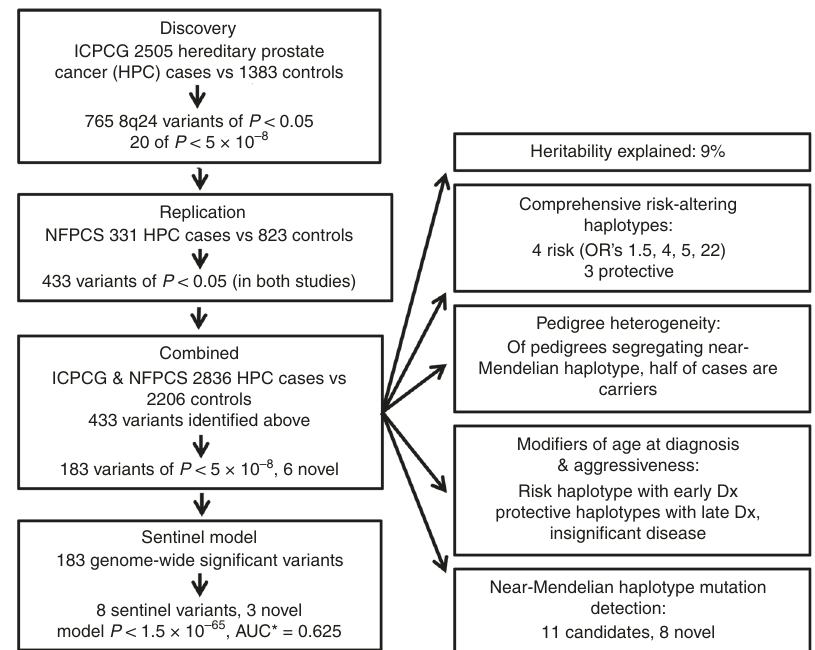
Fig. 1 Study overview. HPC hereditary prostate cancer, ICPCG International Consortium for Prostate Cancer Genetics, NFPCS Nashville Familial Prostate Cancer Study, Dx diagnosis. *Shrunken area under the receiver operator characteristic curve